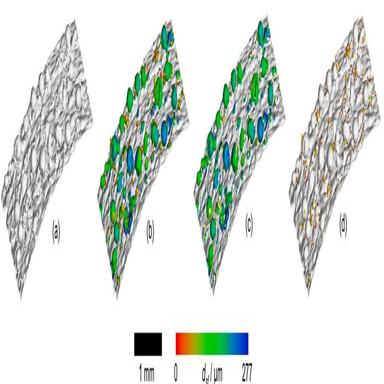
Example of AlSI10 surface topography extracted from CT data (a), feature-based characterization (b), and separation of spatter particles (c) and powder particles (d) sintered onto the surface.